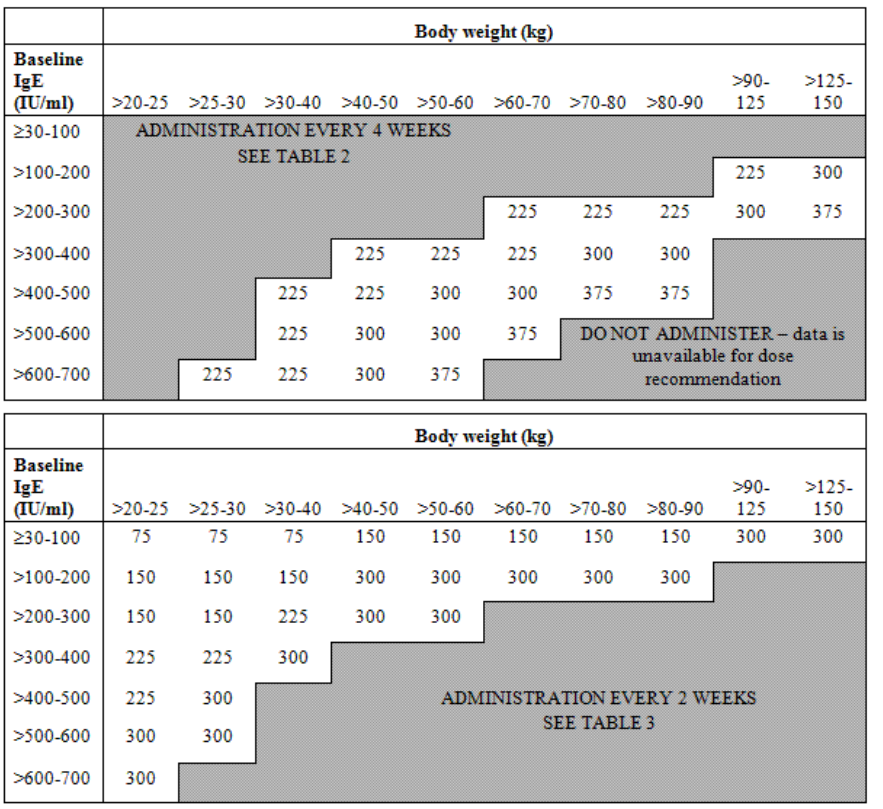
Figure 3. Omalizumab dosing